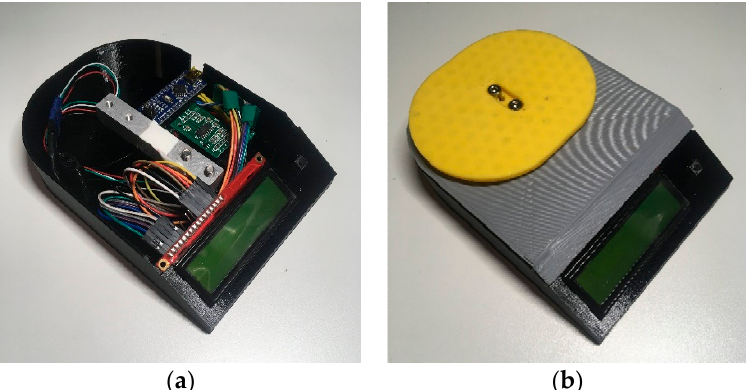
Figure 7. ( a ) The TAL221 load cell should be installed with the wires leading o ff the end of the load cell attached to the base—the M5 tapped holes. Please note that the button is also installed. ( b ) After Figure 7. (a) The TAL221 load cell should be installed with the wires leading off the end of the load snapping on the lid, the bed can be attached to the free end of the load cell using two M4 cell attached to the base — the M5 tapped holes. Please note that the button is also installed. (b) After